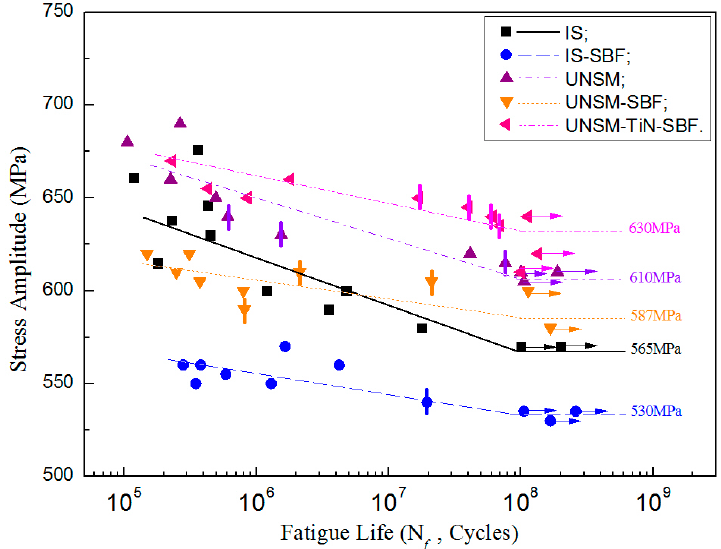
Figure 8. S-N curves of TC4 pre-soaked in SBF for 2 weeks.